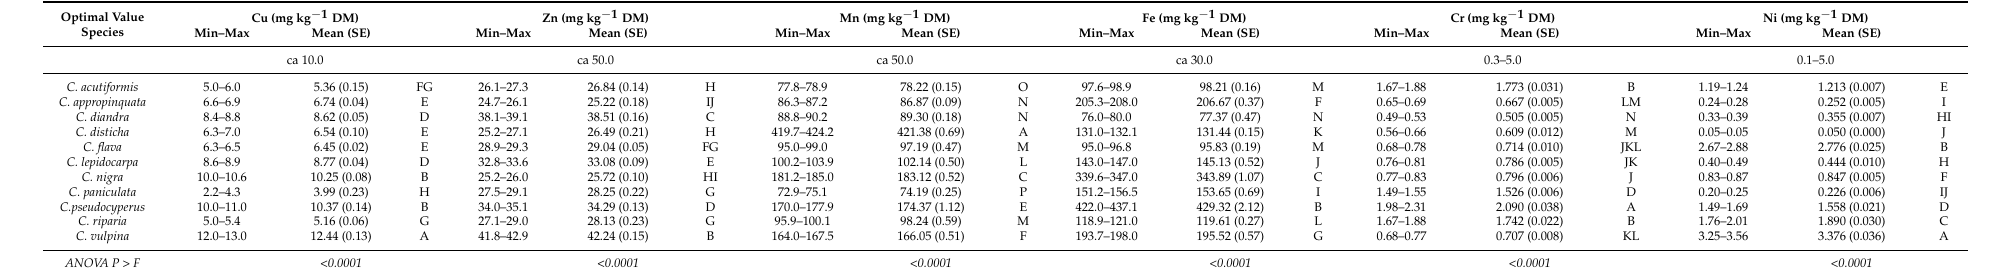
Table 6. Ranges (min–max) and mean values ( ± SE) of six trace elements content in aboveground biomass of the Carex taxa. One way analysis of variance (ANOVA) were performed separately for C, N, and C–N. The same letters indicate a lack of statistically significant differences among species analysed according to Tukey’s a posteriori test ( p < 0.05). OptimalValue